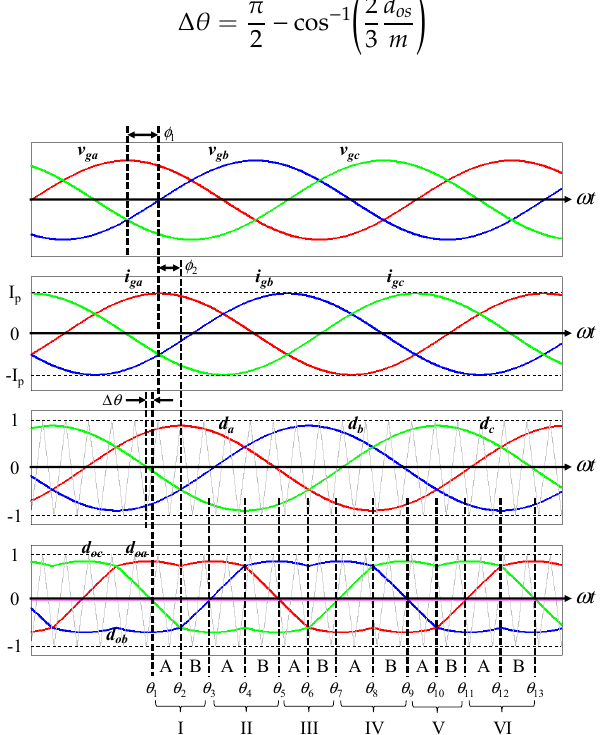
Figure 3. Theoretical operational waveforms.